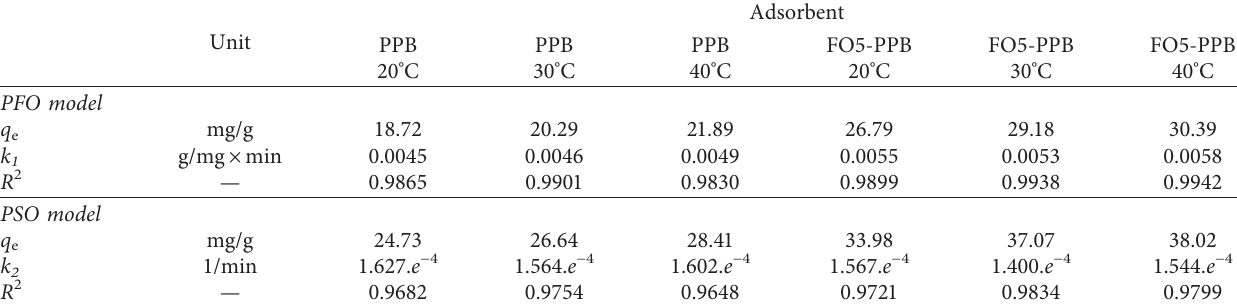
Table 2: RR21 adsorption parameters of selective kinetic modes at different